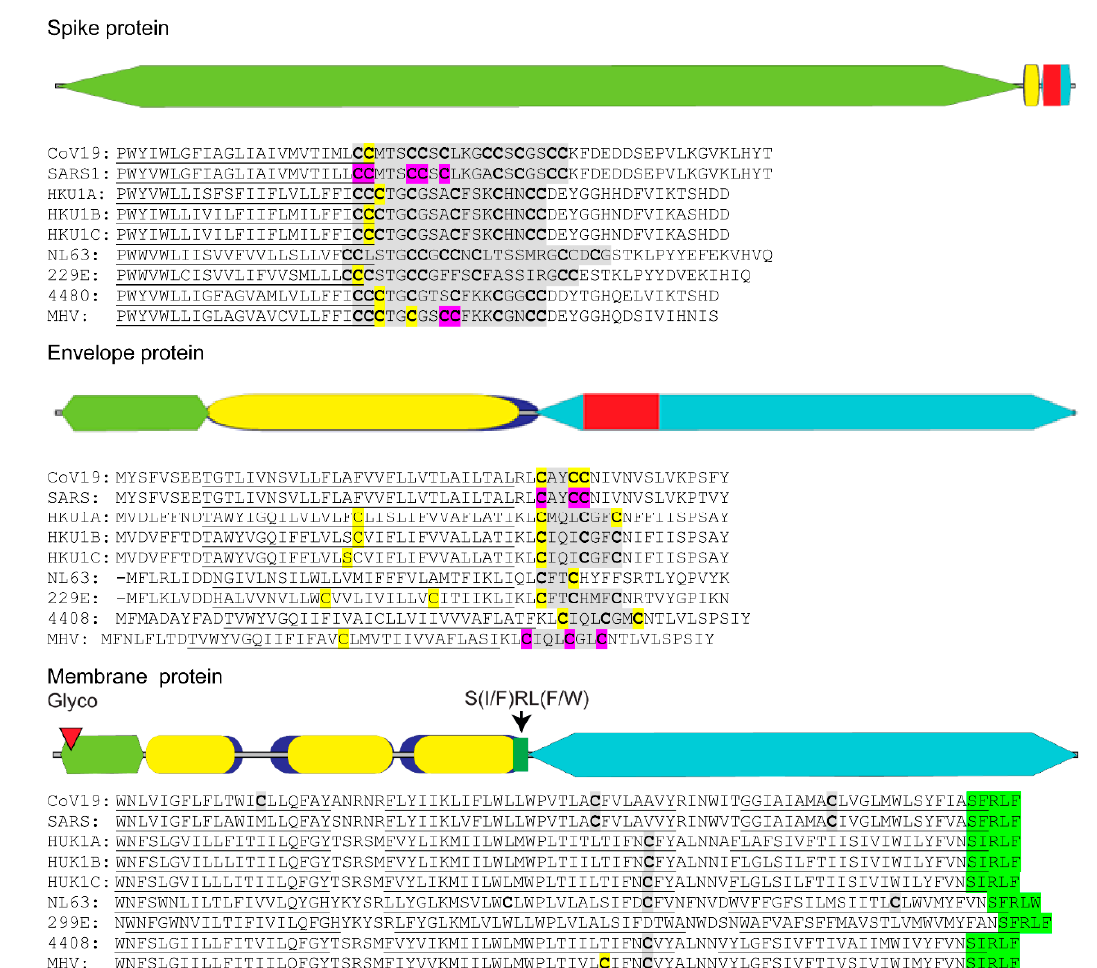
Figure 1. Distribution of palmitoylated cysteine residues in coronavirus structural proteins. Diagram of SARS-CoV-2 spike, envelope and membrane proteins depicting the relative amino acid length of their ectodomain (olive green), hydrophobic domain (blue) with internal transmembrane sequences (mustard), endodomain (teal), N -glycosylation (maroon triangle), conserved S(I/F)RL(F/W) motif (bright green) and cysteine clusters of proven palmitoylation (red). Actual sequences of cysteine clusters (grey highlight) with individual cysteine residues (bold) found in or near predicted transmembrane domains (underlined) for human and mouse coronavirus spike, envelope and membrane proteins are shown. In silico predicted individual cysteines (yellow) and biochemically confirmed (purple) palmitoylation sites are shown. Coronavirus spike, envelope and membrane protein amino acid sequences were derived from GenBank accession IDs for SARS-CoV-2, NC_045512; SARS-CoV-1, AY291315; human coronavirus HUK1 genotype A, AY597011; HUK1 genotype B, AY884001; HUK1 genotype C, DQ415898; human coronavirus NL63, NC_005831; 299E, AF304460; human enteric coronavirus strain 4408, FJ938067; and related murine hepatitis virus strain A59 MHV, MF618252. Coronavirus protein alignments with hydrophobic transmembrane locations were performed using Clustal Omega and TMHMM v. 2.0 programs, respectively. Identification of potential palmitoylation targets was performed using CSS-lm 4.0 and Palm-GPS algorithms set for high stringency.